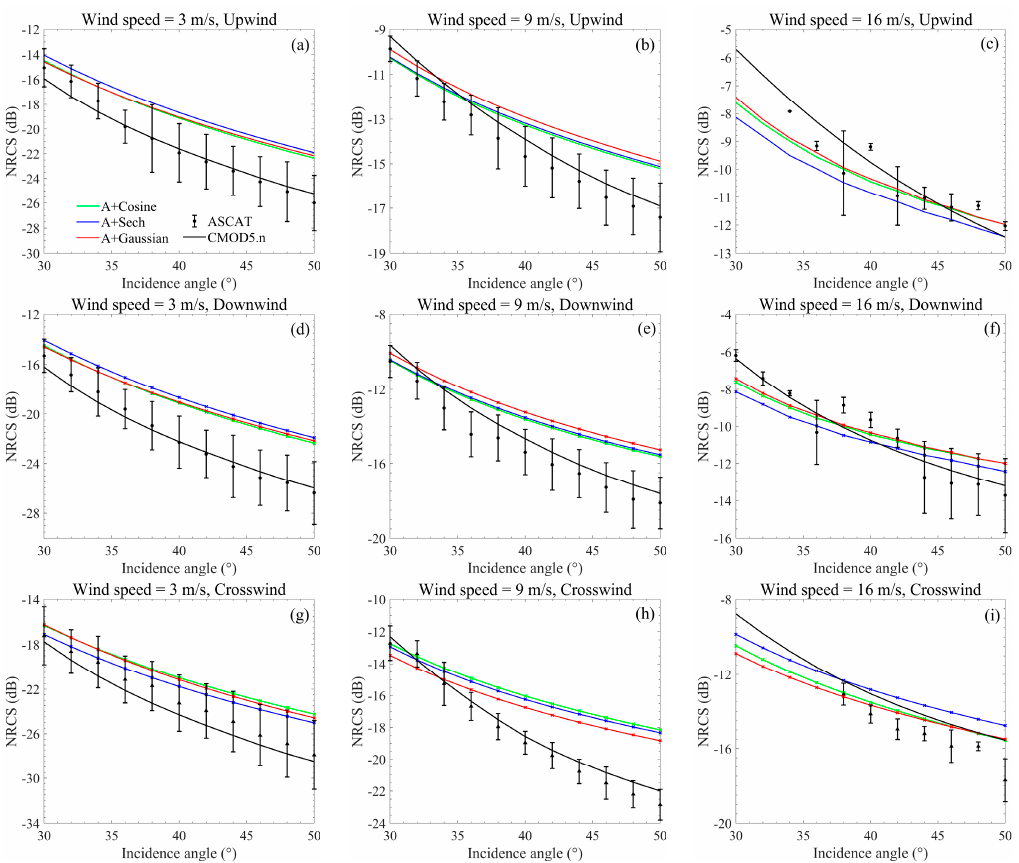
Figure 7. Simulated NRCSs based on A + Cosine, A + Sech, and A + Gaussian, and their comparison with the ASCAT data and CMOD5.n as functions of incidence angle at wind speeds of 3 m/s, 9 m/s, and 16 m/s in the ( a – c ) upwind direction, ( d – f ) downwind direction, and ( g – i ) crosswind